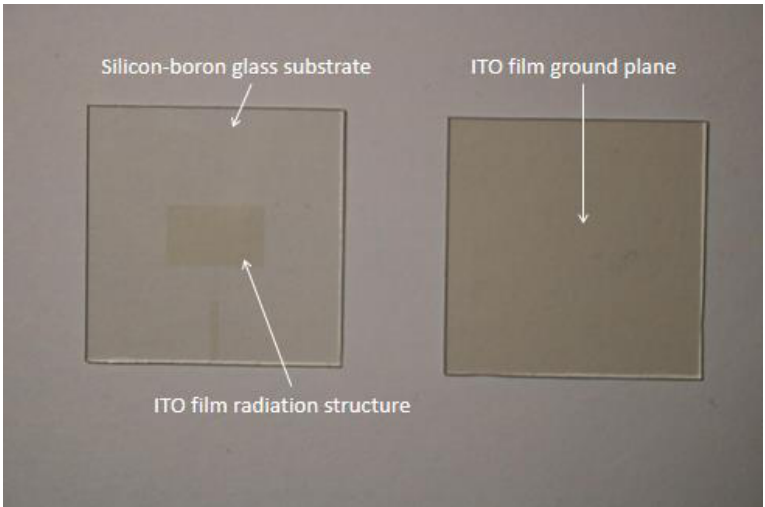
Figure 3. The ITO film deposited on glass. The image on the left is the top view; the image on the right is the bottom view.